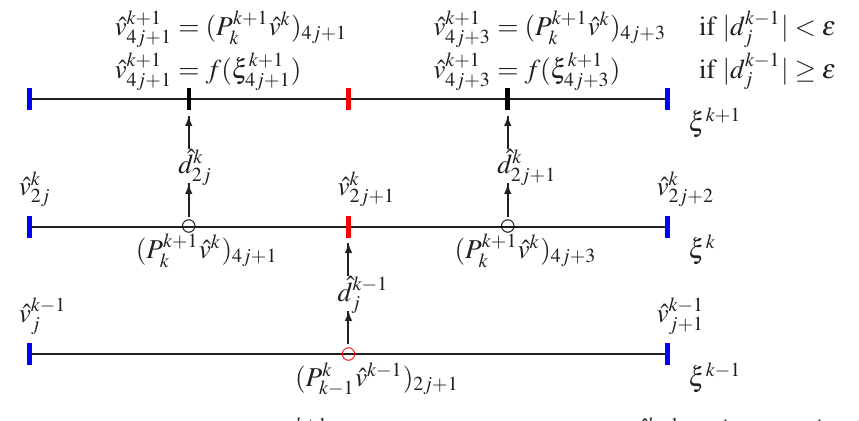
Fig. 1 Sketch of recurrence (9). The value of ˆ v k + 1